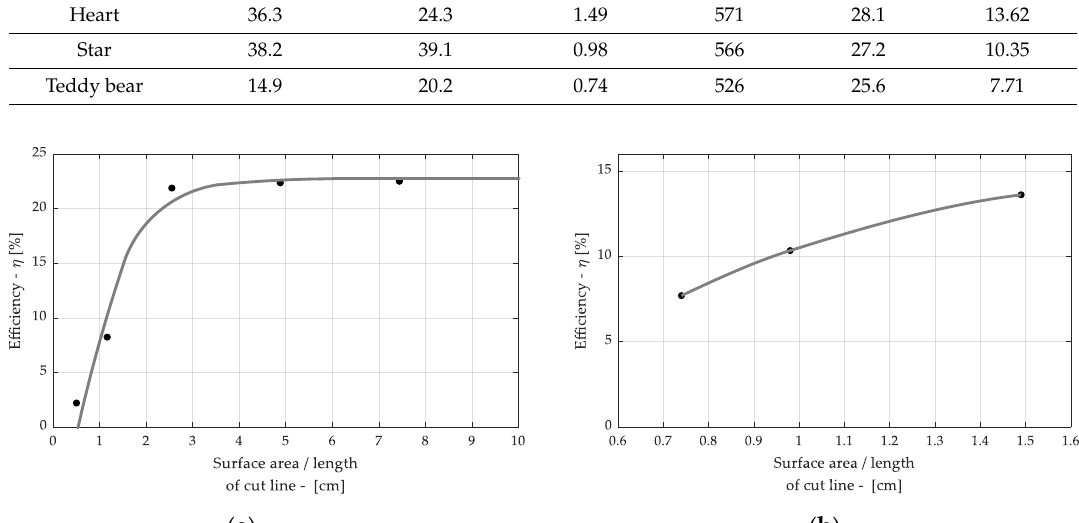
Figure 9. Functional efficiency dependence on S/L ratio for cells after the laser cut process. ( a ) Functional e ffi ciency dependence on S / L ratio for cells after the laser cut process. Monocrystalline silicon cell and ( b ) polycrystalline silicon cell. ( a ) Monocrystalline silicon cell and ( b ) polycrystalline silicon